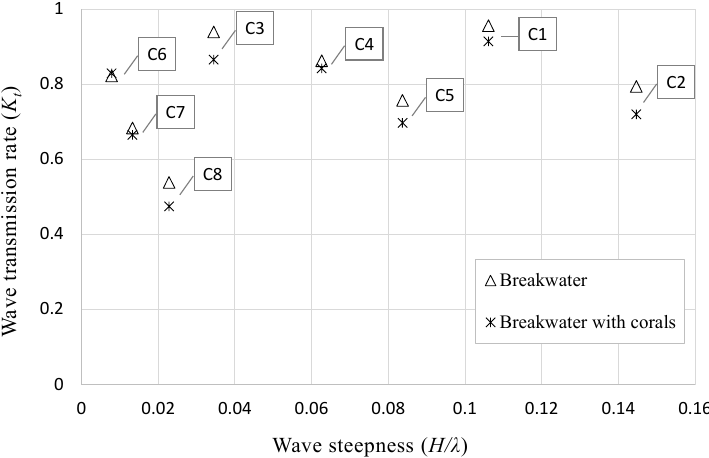
Figure 6. Wave-transmission rate for the two configurations of the reef model under a water depth h = 0.75m.